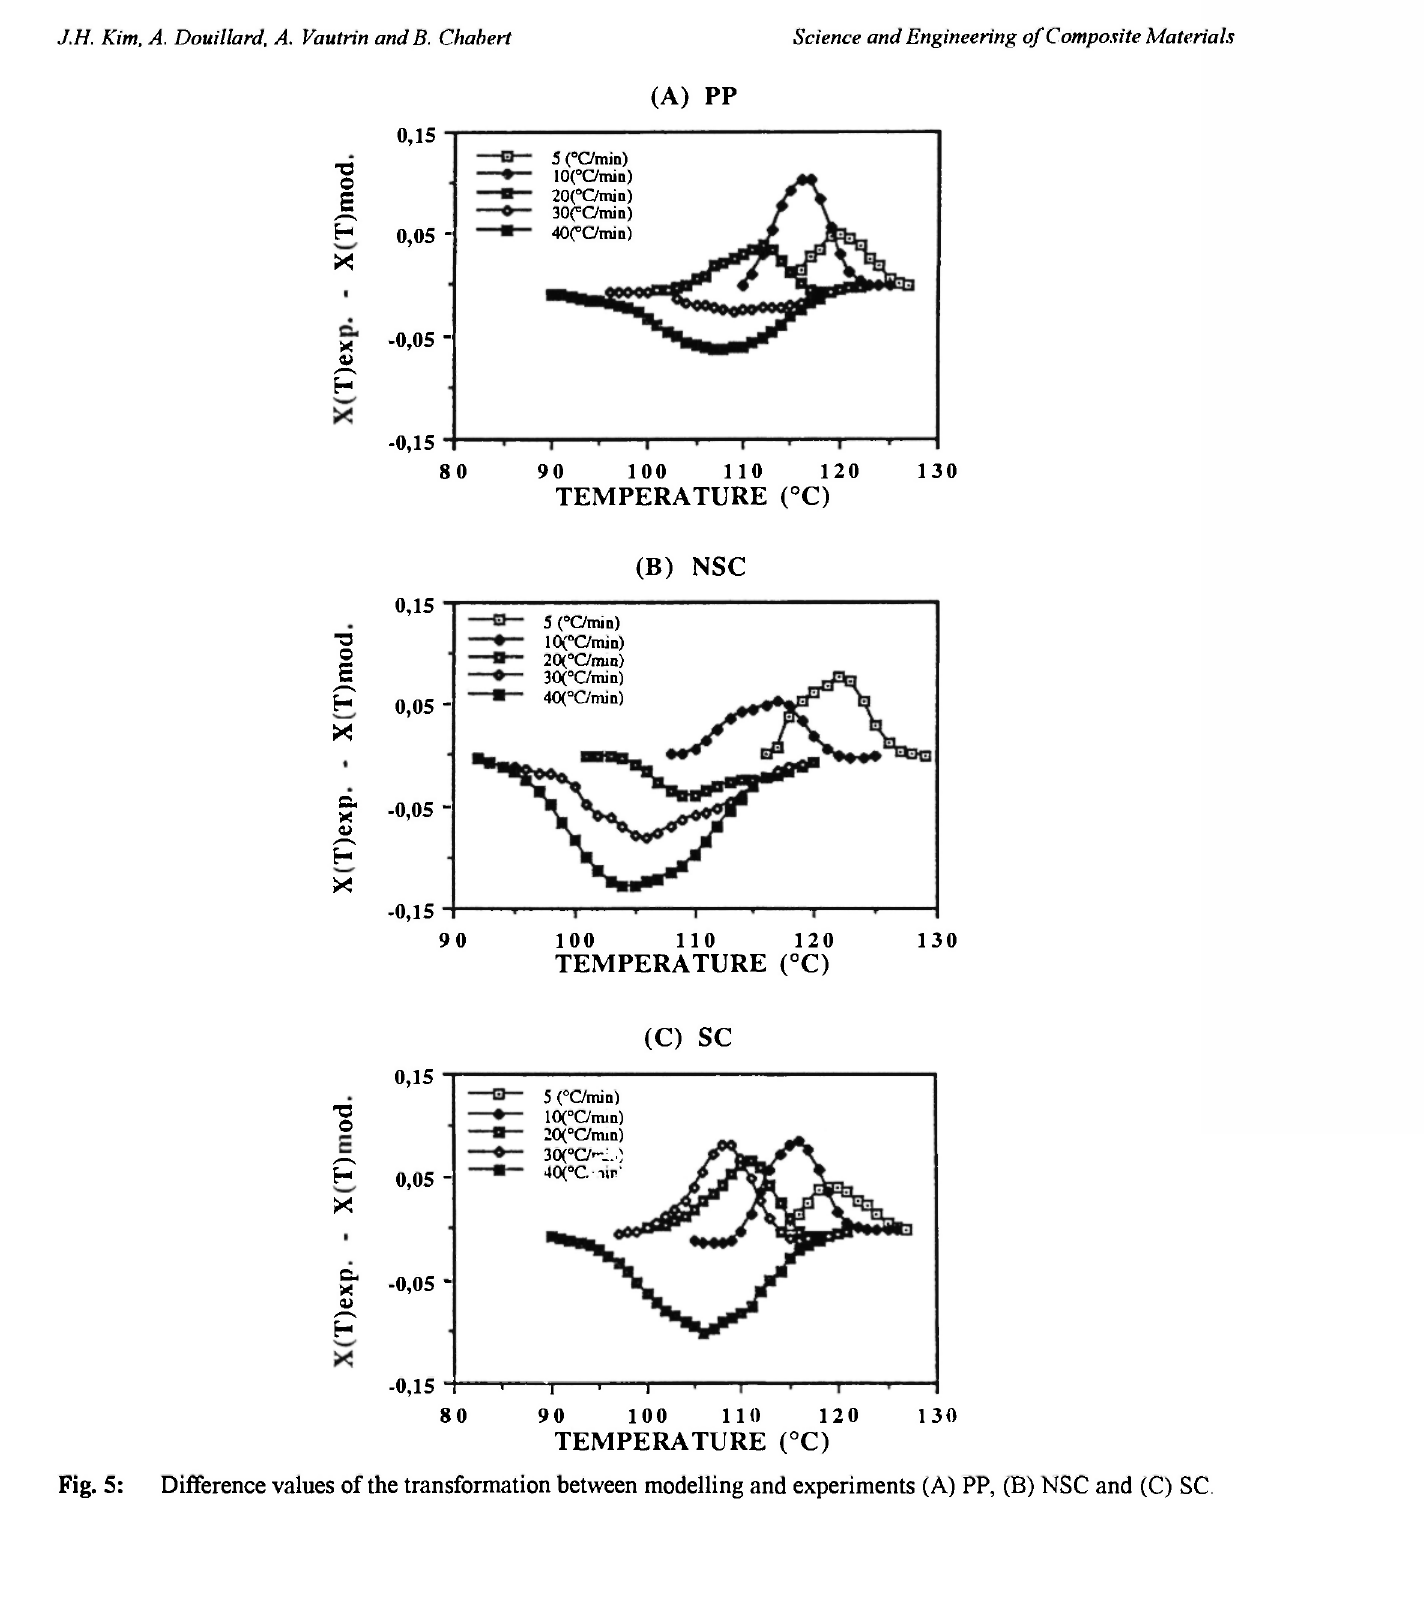
Difference values of the transformation between modelling and experiments (A) PP, (B) NSC and (C)